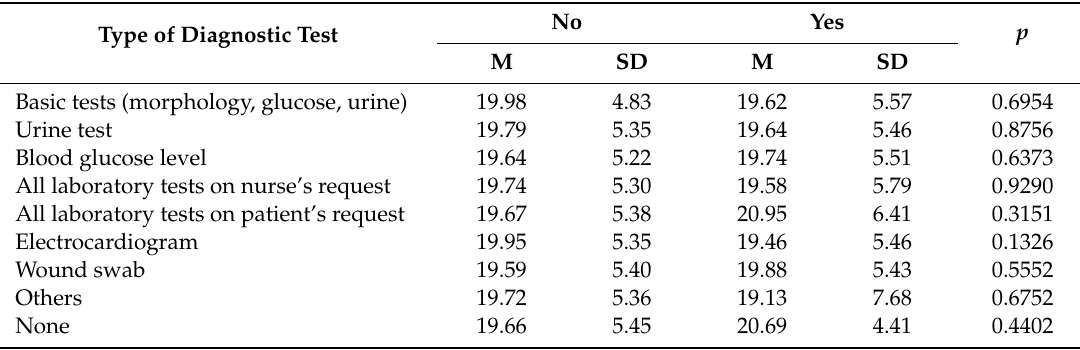
Table 4. Nurses’ self-assessed preparedness for issuing referrals for diagnostic tests and their satisfaction with life (as assessed by SWLS).